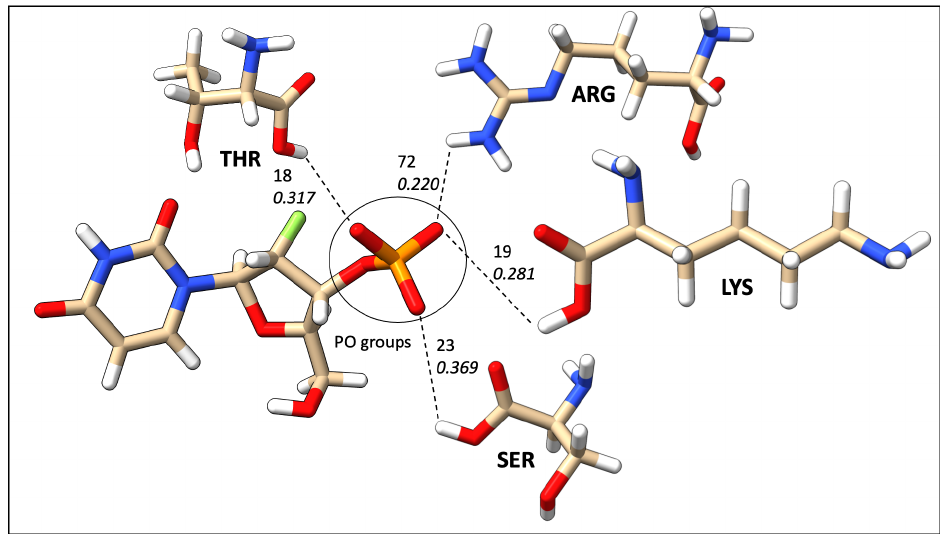
Figure 14. Frequent HBs interactions between the P=O ligand functional group and amino acid residues; the top numerical value mentions the number of HBs, and the bottom value represents the average strength in mDyn/Å from database